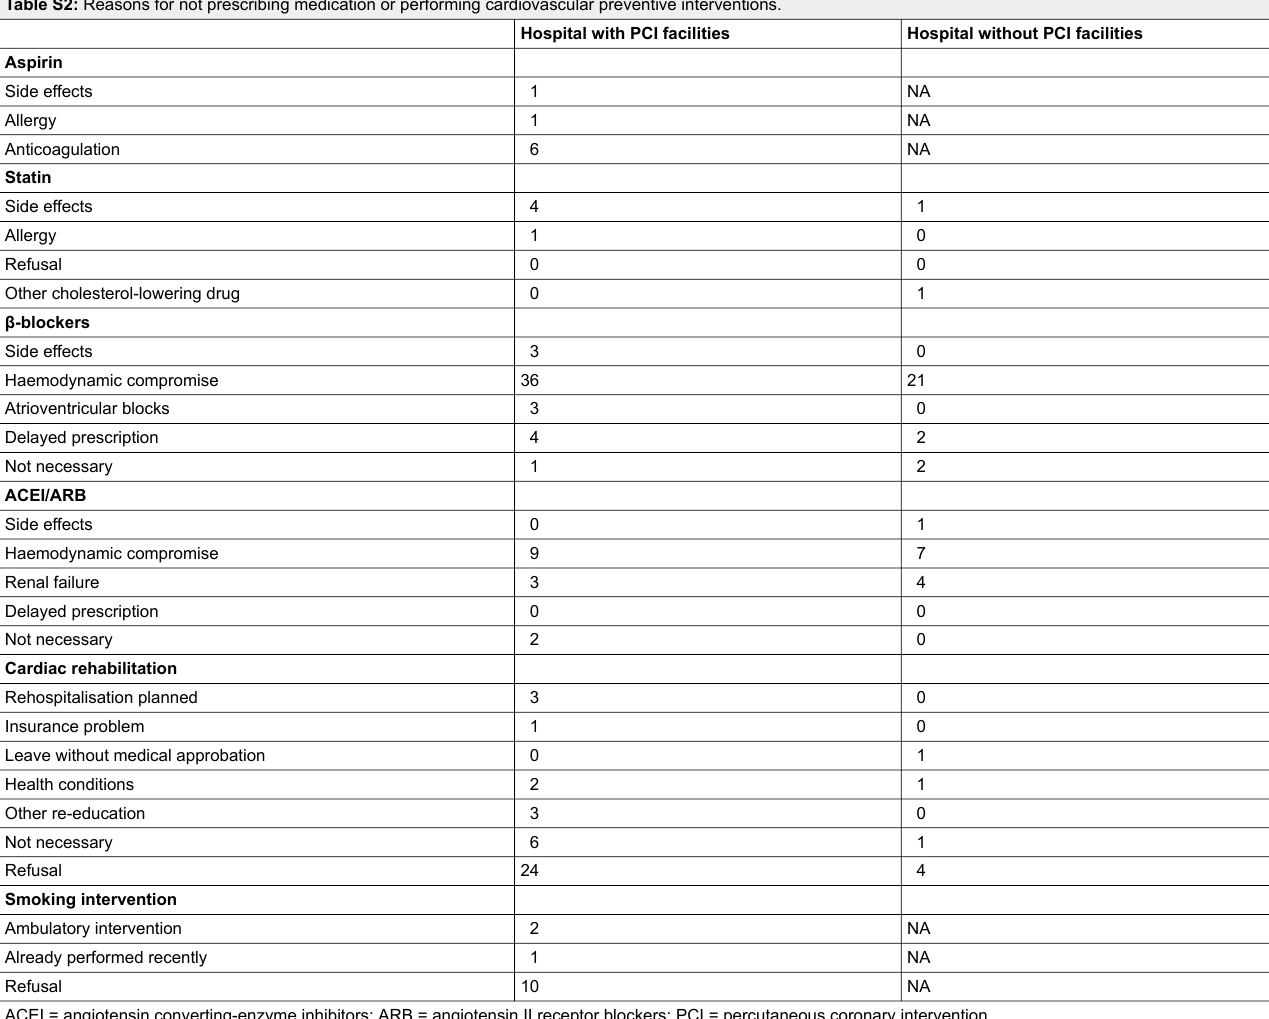
Table S2: Reasons for not prescribing medication or performing cardiovascular preventive